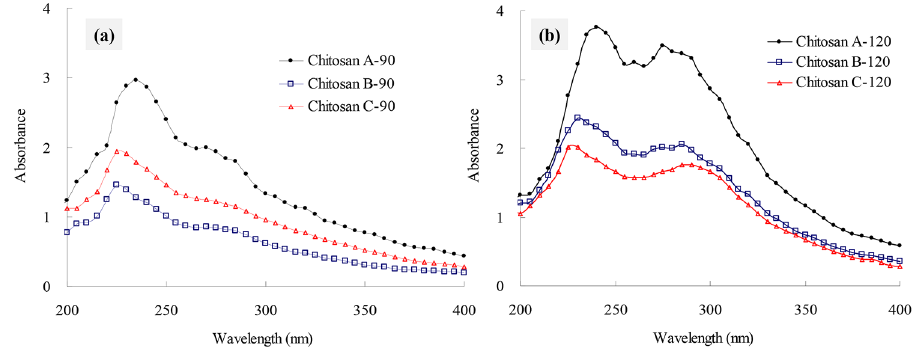
Figure 1. UV absorption spectra of crab shell chitosan by deacetylation at 90 °C ( a ) and 120 °C ( b ).